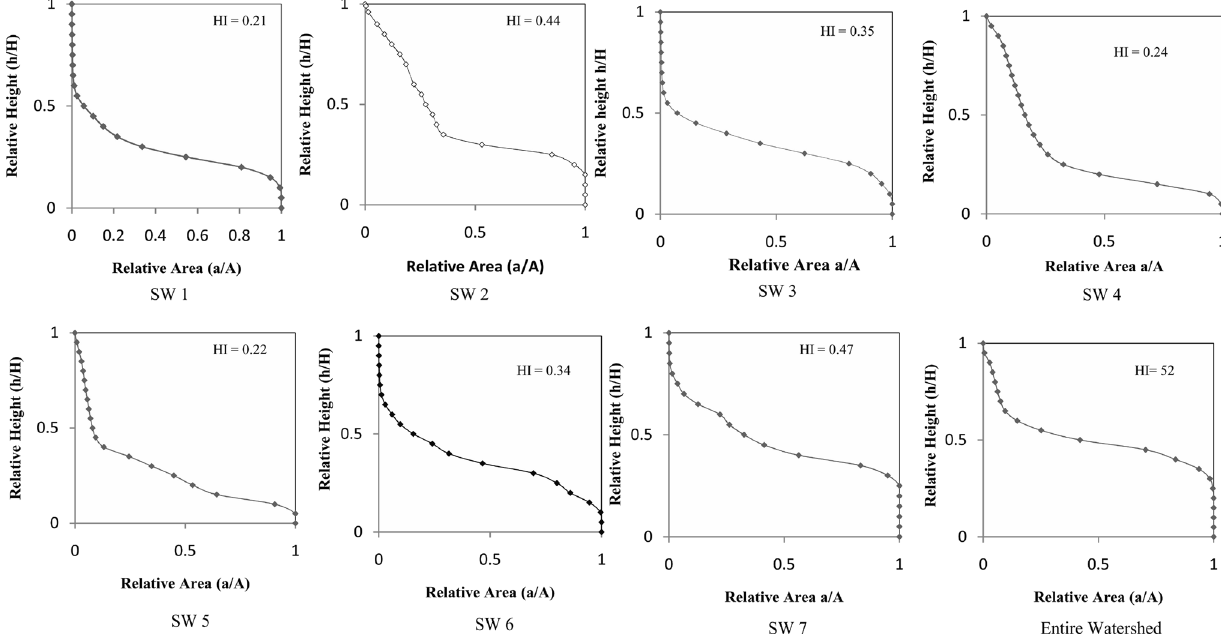
Fig. 7 Hypsometric curve